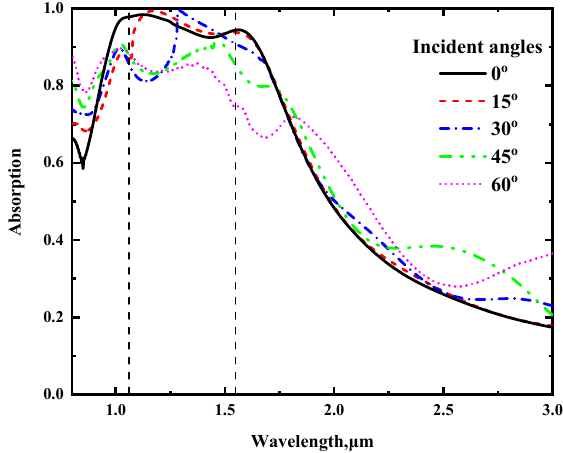
Figure 7. Absorption spectra at different angles of incidence.